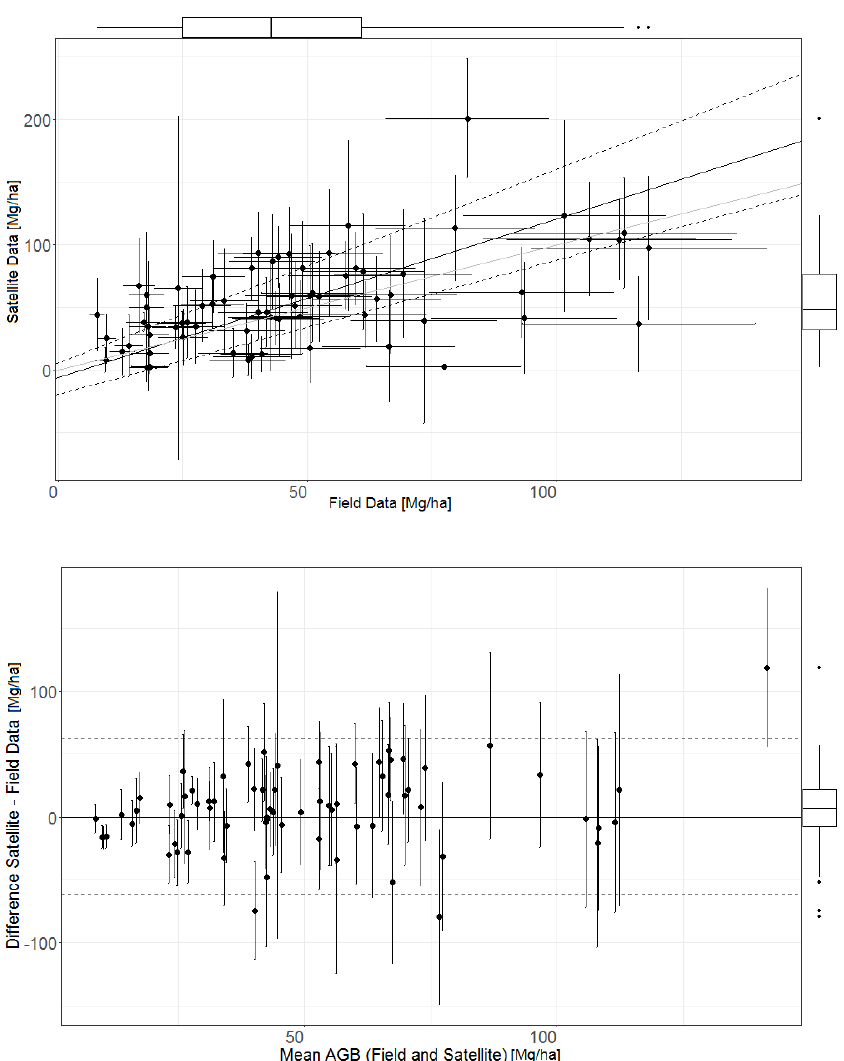
respective Sat500 was grouped based on the description of physiognomy observed in each plot (Figure 5, open and gray boxes respectively). The results quanify the mean biomass in each physiognomy, with the respective variability ranging from thorn woodlands (40 Mg/ha) to mountain evergreen forests (80 Mg/ha). The